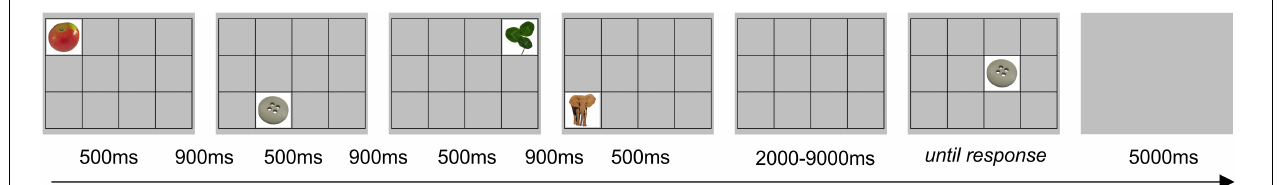
FIGURE 3 | Example of trial for the sequential picture location task (SPLT). The item shown would require a response “no.”